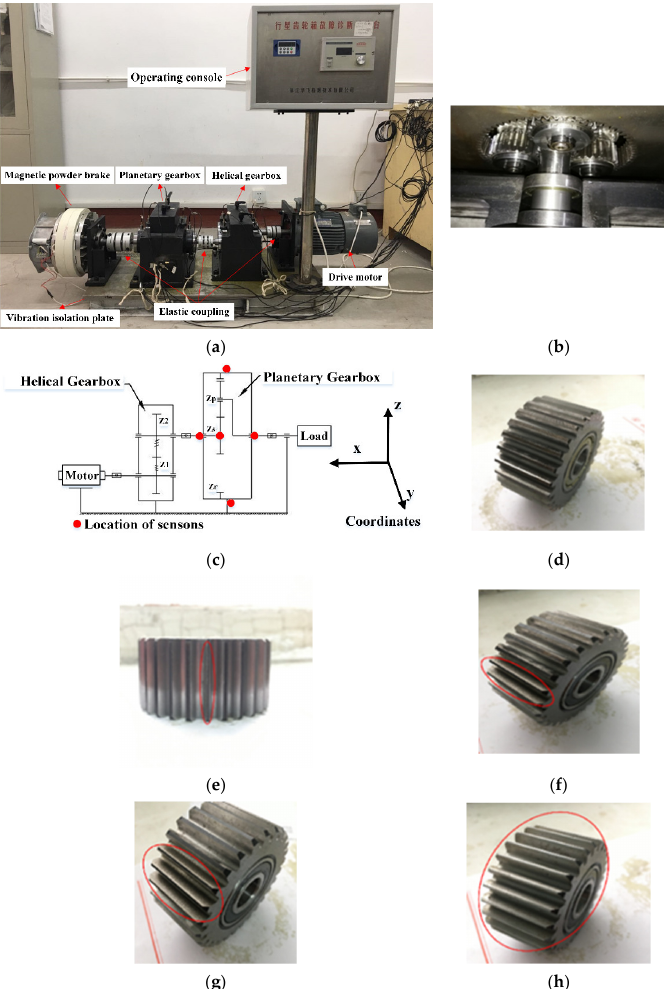
Figure 4. ( a ) Structure of the planetary gearbox test rig, ( b ) The internal structure of planetary gearbox, ( c ) locations of five accelerometer sensors, ( d ) normal state, ( e ) single tooth wear, ( f ) two teeth wear, ( g ) three teeth wear, and ( h ) all teeth wear.